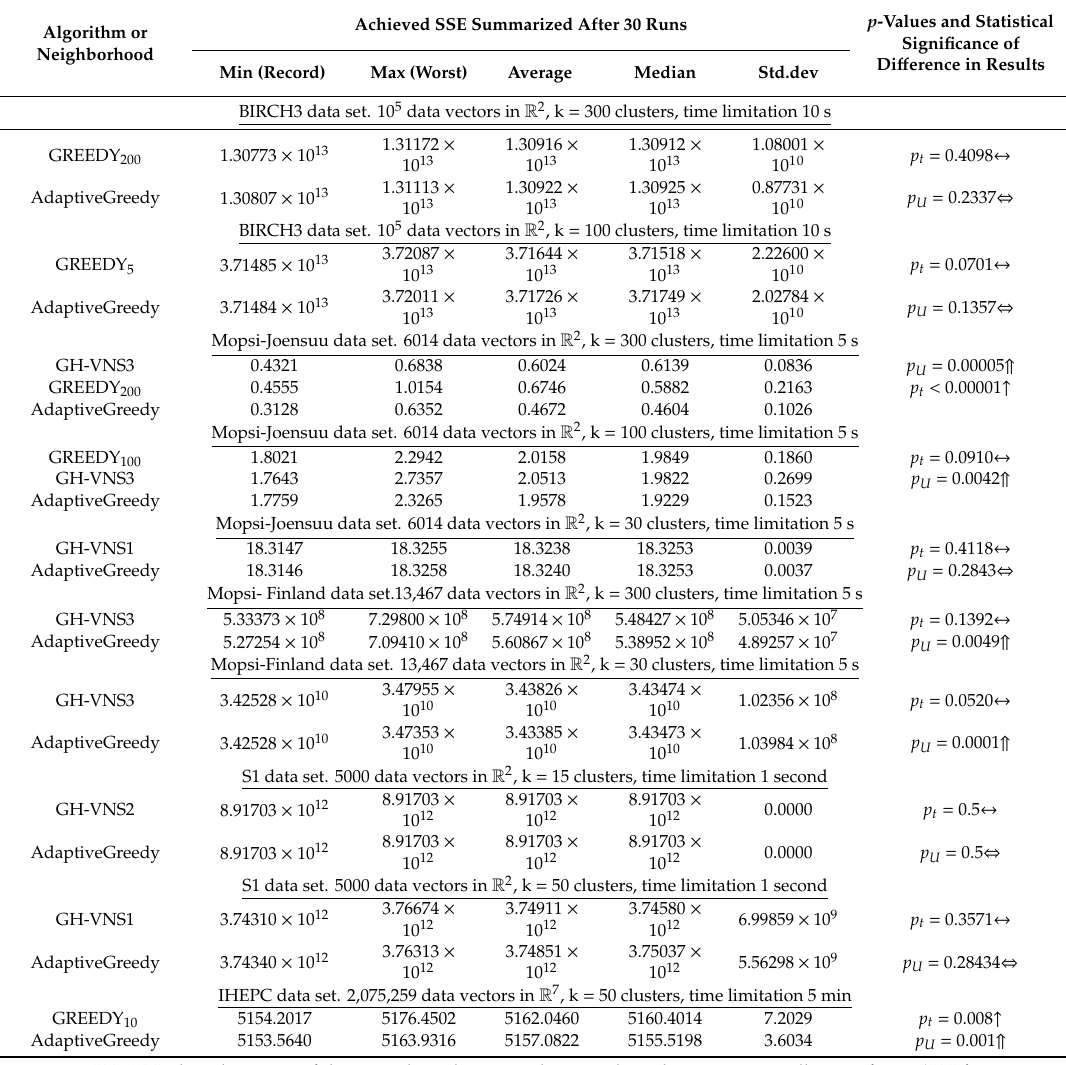
Table 1. Comparative results for all data sets (best of known algorithms vs. new algorithm). Algorithm or